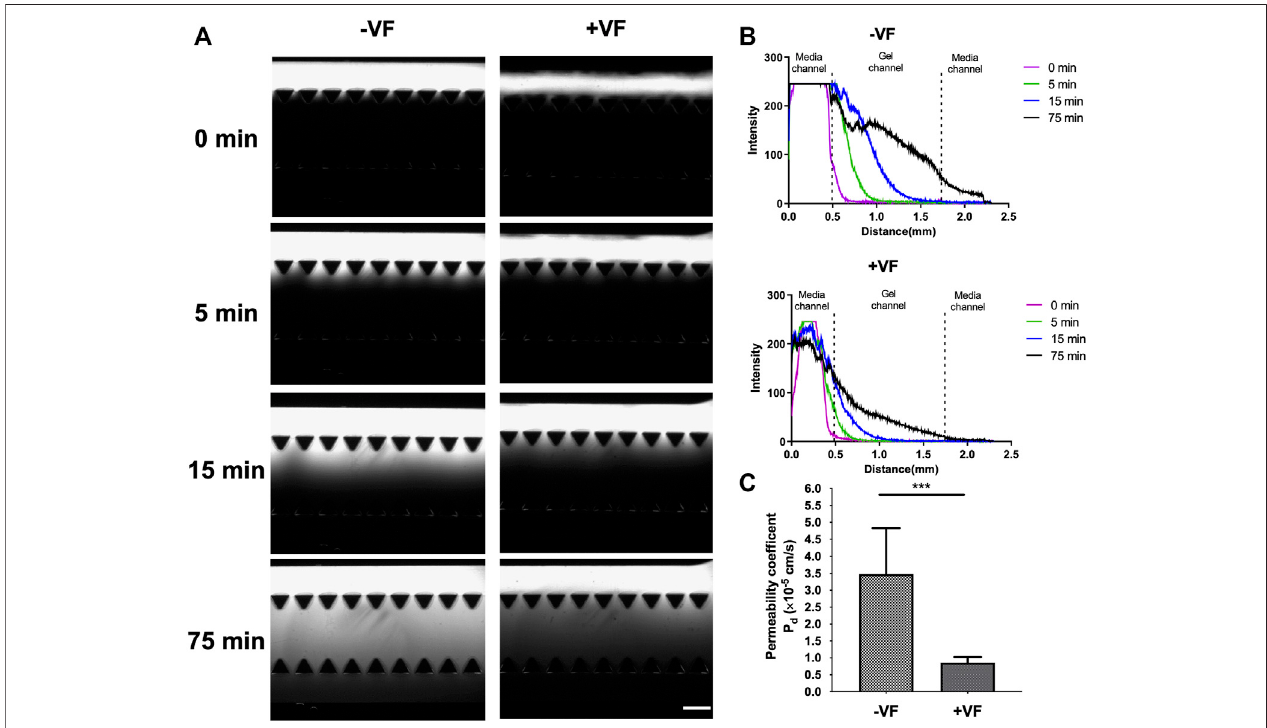
FIGURE 8 | Measurement of permeability in vessels formed in the device without or with VF collagen lumen. (A) Fluorescent images of the 70 kDa FITC-dextran incubated in the lumen and observed at 0, 5, 15 and 75 min withoutor withVF collagen lumen. Scale bar: 500 µm. (B) Intensity maps ofFITC-dextran observed without or with the VF collagen lumen at 0 (purple), 5 (green), 15 (blue) and 75 (black) min. (C) Permeability coef fi cient calculated from the fl uorescent time-lapse images without ( n = 4) and with the VF collagen lumen ( n = 3).